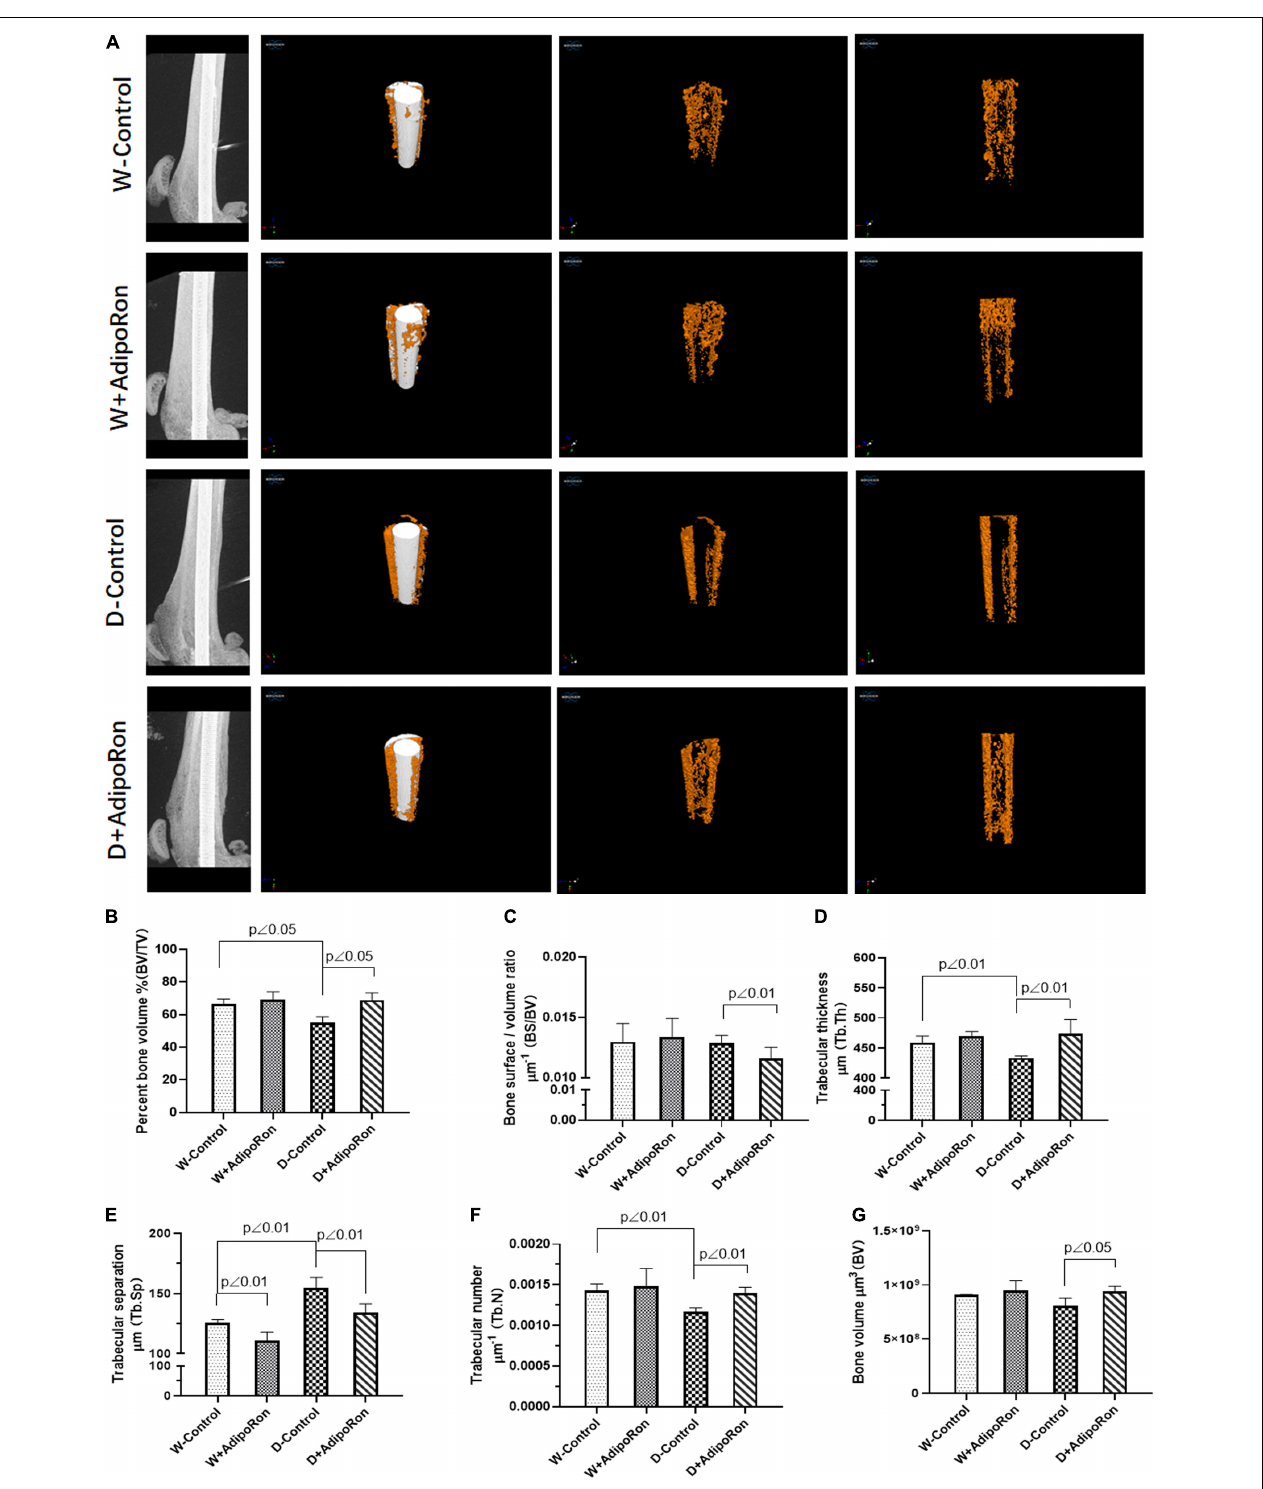
FIGURE 1 | Evaluation of femoral bone structure with dental implants in mice. Femoral bone structure with dental implants in mice was assessed using micro-CT ( n = 7). Normal mice (Wild-control, W-control), normal mice treated with AdipoRon (Wild + AdipoRon, W + AdipoRon), diabetic mice (Diabetes-control, D-control), and diabetic mice treated with (Diabetes + AdipoRon, D + AdipoRon) were involved. (A) 3D reconstruction images of femoral bone structure with dental implants in mice are shown. Values of bone volume/tissue volume (BV/TV) (B) , bone surface/bone volume (BS/BV) (C) , trabecular thickness (Tb.Th) (D) , trabecular separation (Tb.Sp) (E) , trabecular number (Tb.N) (F) , and bone volume (BV) (G) were analyzed.